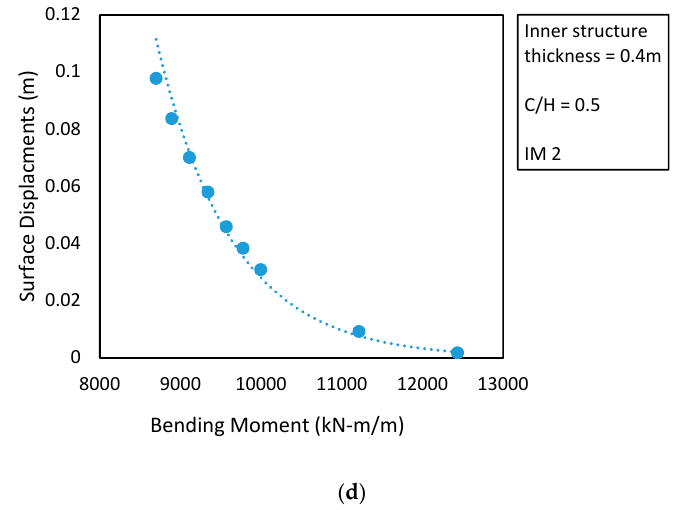
Figure 4. ( a – d ) Effect of variation in the lining thickness on ( a ) surface settlements, ( b ) normalized tunnel deformations, ( c ) resisted bending moments, and ( d ) surface displacements vs. bending moments.